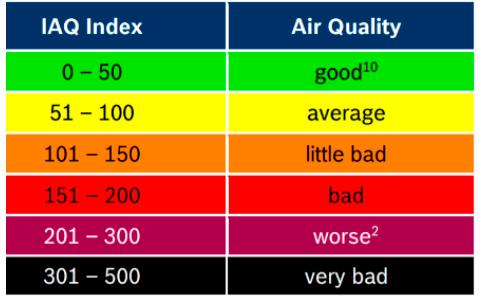
Figure 5. BME680 Indoor Air Quality (IAQ) and Color Coding according to the datasheet .